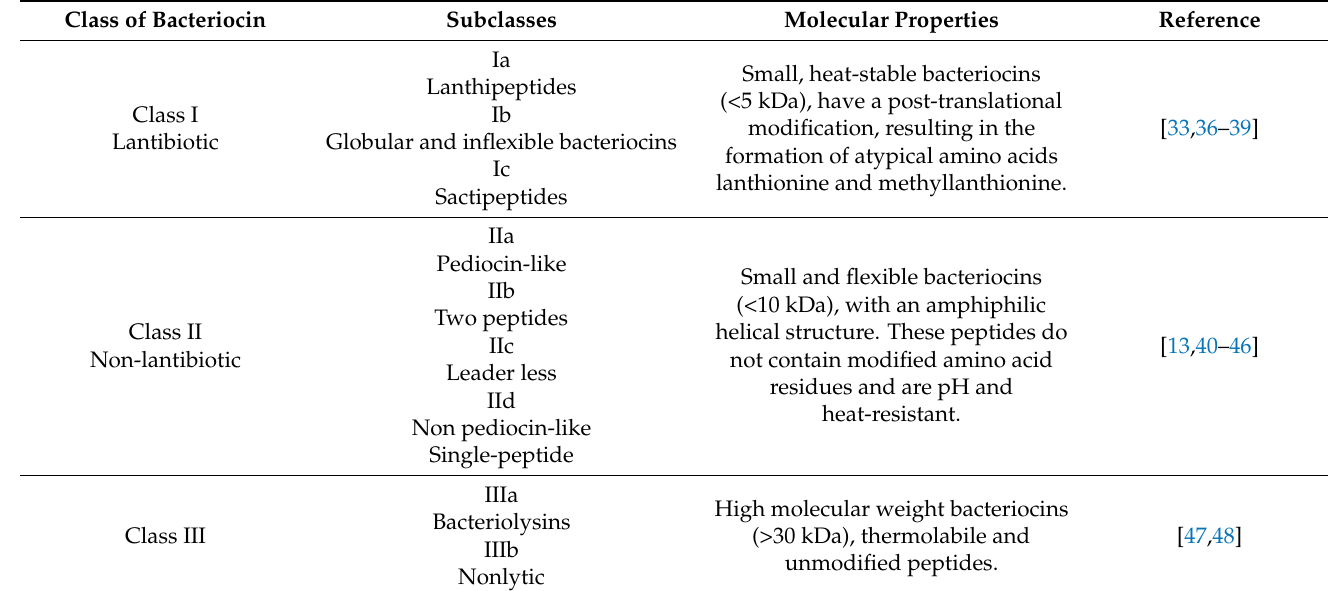
Table 1. Classification of